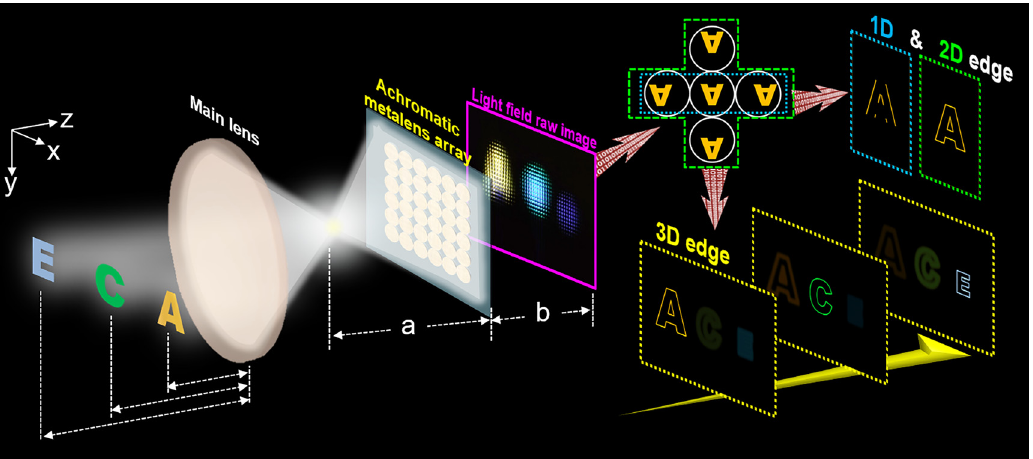
Figure 1: Schematic diagram of multidimensional edge detection with light-field imaging system by the achromatic meta-lens